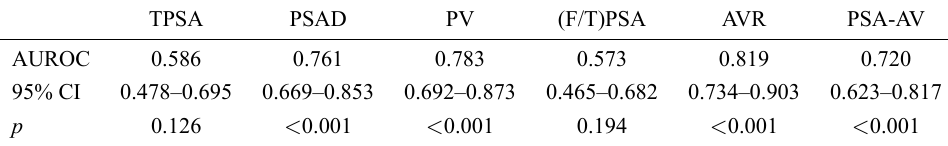
Table 2. AUROC values and 95% CIs for various parameters in the diagnosis of PCa.